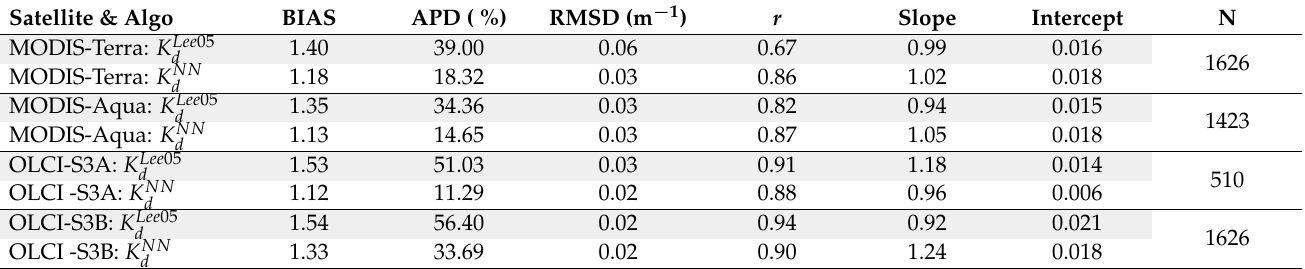
Table 4. Comparison of performance statistics at the global scale of the K d (412 nm) for the MODIS and OLCI sensors at the global scale and K d (412 nm) algorithms. See Methods section for the definitions of the